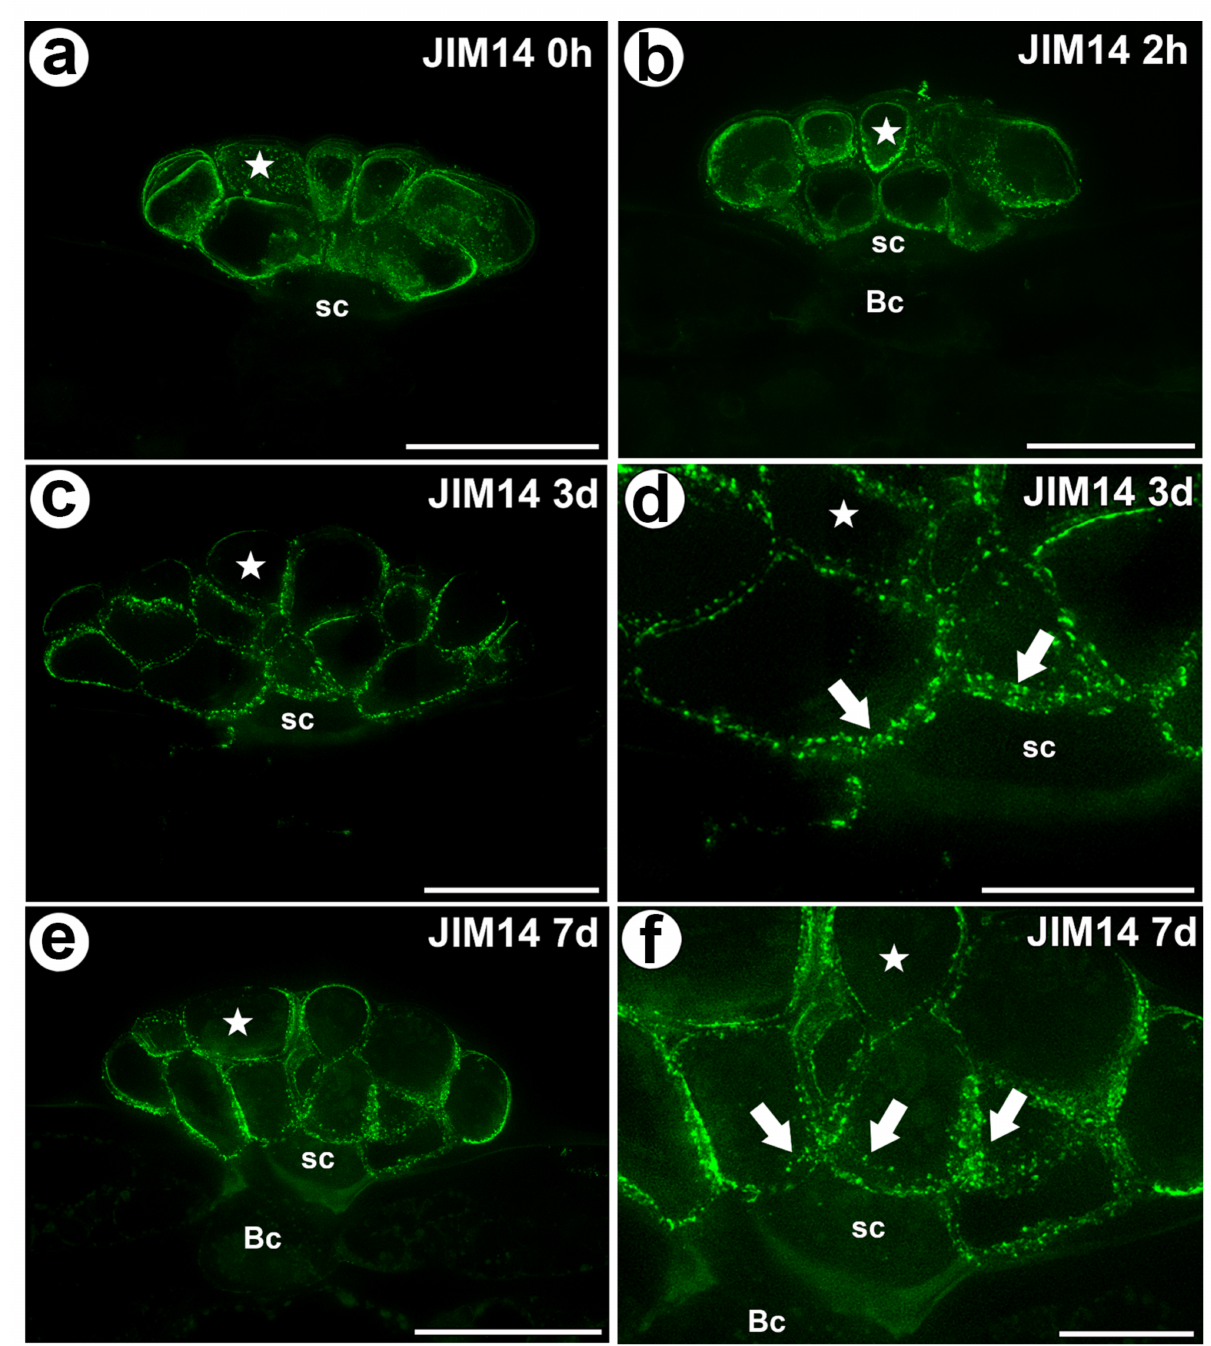
Figure 2. The arabinogalactan proteins (labeled with JIM14) that were detected in a D. muscipula trap. ( a ) Immunolabeling of AGP with JIM14 that were detected in the gland from an unfed trap: secretory cell (star), stem cell (sc), bar 20 µ m. ( b ) Immunolabeling of AGP with JIM14 that were detected in a gland two hours after feeding: secretory cell (star), stem cell (sc), basal cell (Bc), bar 20 µ m. ( c ) Immunolabeling of AGP with JIM14 that were detected in a gland three days after feeding: secretory cell (star), stem cell (sc), bar 20 µ m. ( d ) The magnification from (c)—cell wall ingrowths (arrows) in secretory cells (star), stem cells (sc), bar 10 µ m ( e ) Immunolabeling of AGP with JIM14 that were detected in a gland seven days after feeding: secretory cell (star), stem cell (sc), basal cell (Bc), bar 20 µ m. ( f ) The magnification from ( e )—cell wall ingrowths (arrows) in secretory cells (star), stem cells (sc), bar 10 µ m. All photos are maximum projections from